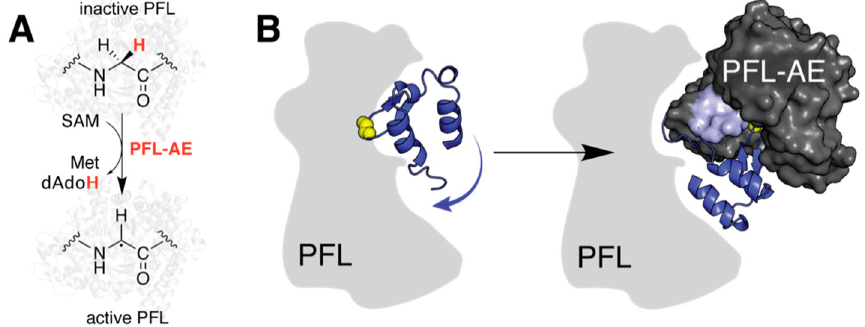
Figure 2. Large-scale structural rearrangements of PFL and its activating enzyme. ( A ) Reaction catalyzed by PFL-AE. ( B ) Docking studies suggest hinged motion of the radical domain in PFL (blue cartoon, PDB accession code: 2PFL) together with loop motions in PFL-AE (PDB accession code: 3CB8, mobile loop region highlighted on surface) facilitate substrate positioning. The outline of PFL is predominantly shown as a solid grey shape to help distinguish the radical domain. The catalytic glycine residue is rendered in yellow spheres for emphasis. Note the complex depicted here is not the original docking model and was generated manually for visualization of described computational results.